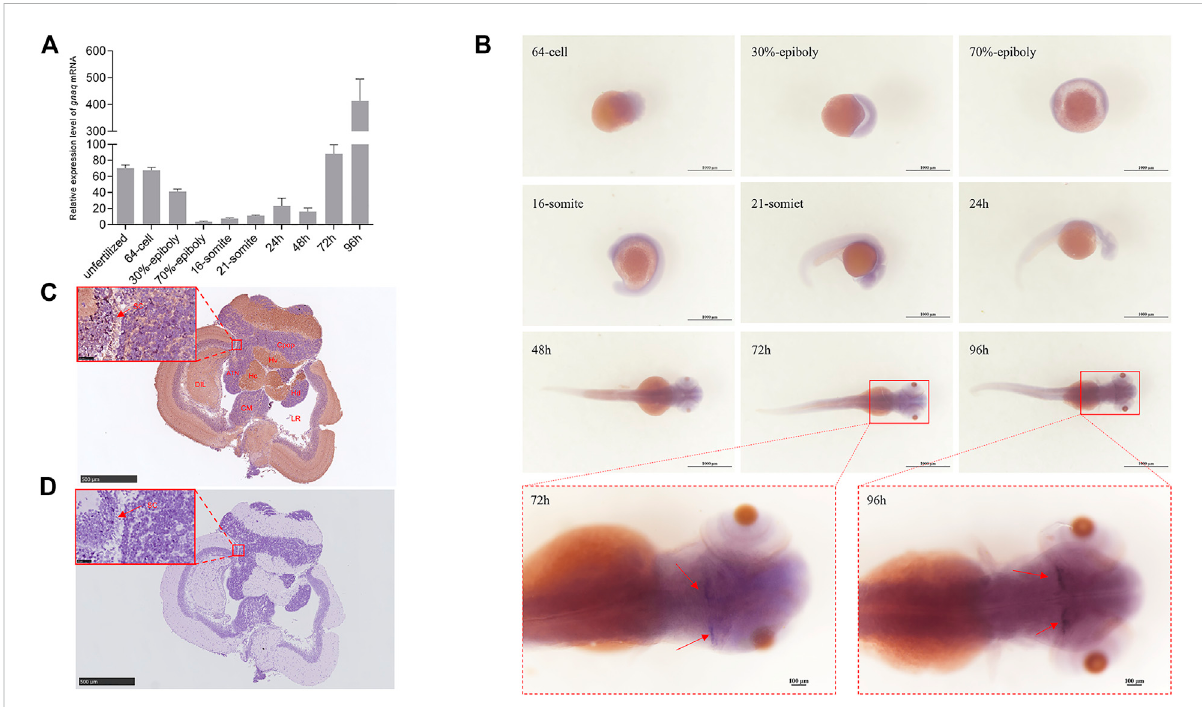
FIGURE 3 Expression anddistribution ofgnaqmRNAduring embryonicdevelopmentandG α qinsectionofhypothalamus. (A) Relativeexpressionof gnaq mRNA in the embryonic development stage; Error bars indicate mean ± SEM, n = 3; one-way ANOVA was used for statistical analysis ( p < 0.05). (B) whole-mount in situ hybridizations of gnaq ; stage: 64-cell, 30%-epiboly, 70% - epiboly, 16-somite, 21-somite, 24 h, 48 h, 72 h, and 96 h. Scale